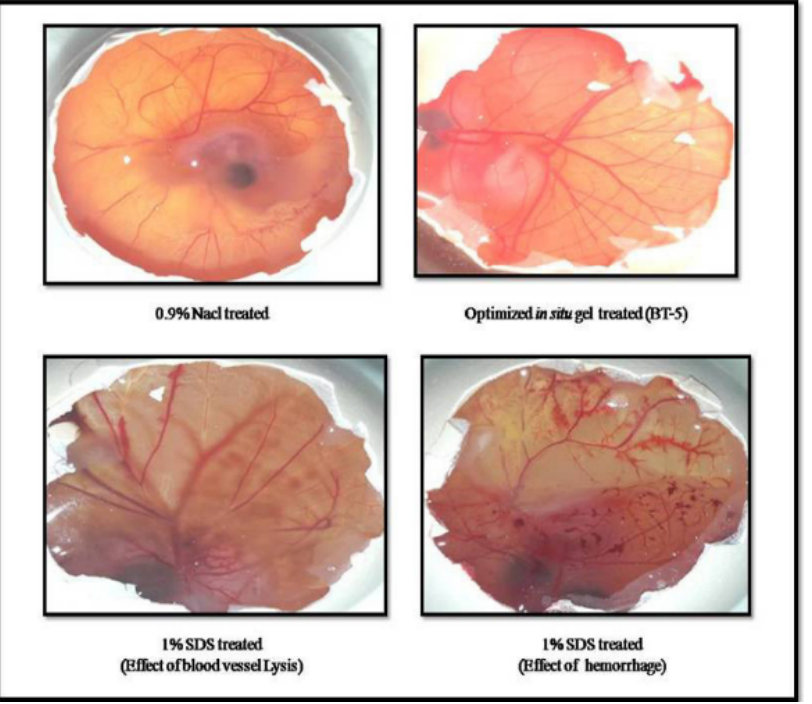
Figure 2. HET-CAM test for optimized formulation. Each of the eggs is treated with 0.9% NaCl (negative control), 1% sodium dodecyl sulfate (SDS) (positive control), and optimized formulation, respectively. The mean irritation score obtained for the negative control, positive control, and the optimized formulation was 0.04 (no irritation), 14.07 (severe irritation), and 0.05 (no irritation), respectively [25].